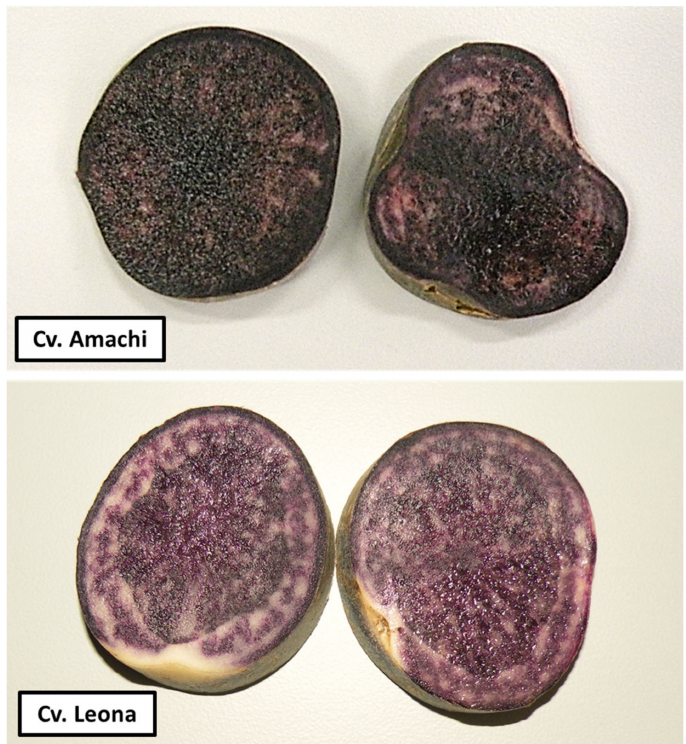
Figure 1. The purple-fleshed potato cultivars Amachi and